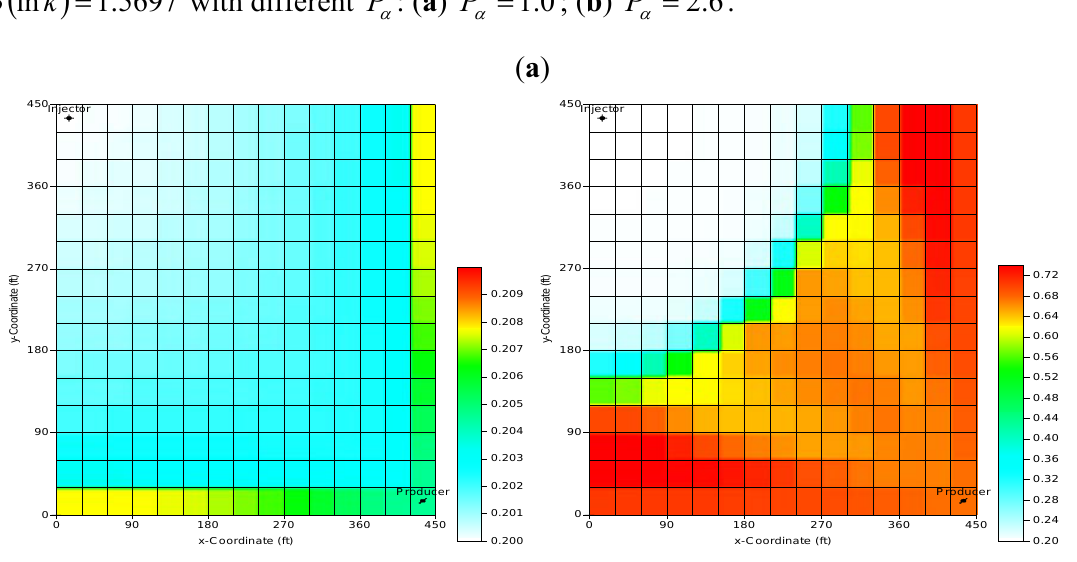
Figure 2. Oil phase saturation of layers 1, 3, and 5 at 1,283 days